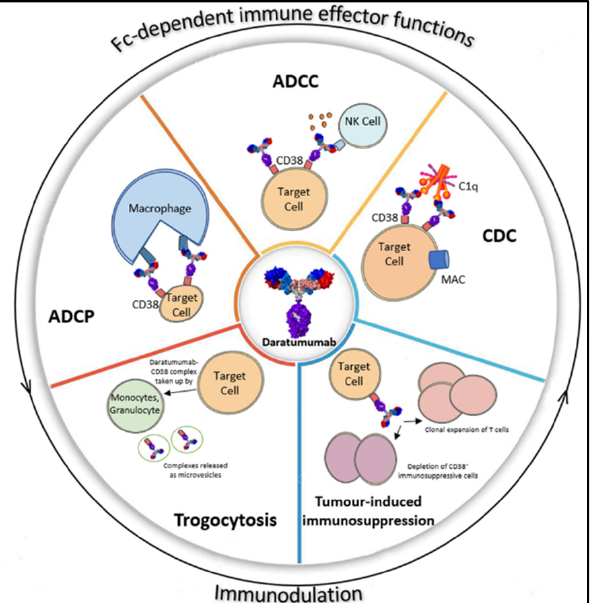
Figure 2. A broad spectrum of mechanisms of action of daratumumab. Daratumumab triggers Fc-dependent immune effector mechanisms that comprise of CDC, ADCC, and ADCP. The Fc tail of daratumumab with the Fc gamma receptors (Fc γ Rs) present on immune effector cells leads to activation of these immune cells and subsequent lytic killing of MM cells. Lysis and depletion of CD38+ immune suppressor cells, such as Tregs, also occur via the same process, leading to immunomodulation of the tumor niche and clonal expansion of cytotoxic T cell. CD38–daratumumab complexes that are formed are transferred from MM cells to monocytes and granulocyte in a process known as trogocytosis, thereby modulating CD38 expression on immune